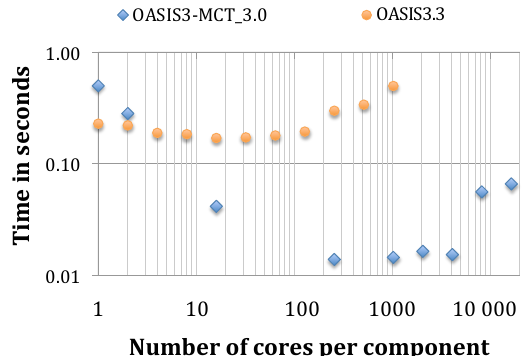
Figure 2. Initialization cost for the T799-ORCA025 toy model us- ing OASIS3-MCT_3.0 on Curie Bullx.